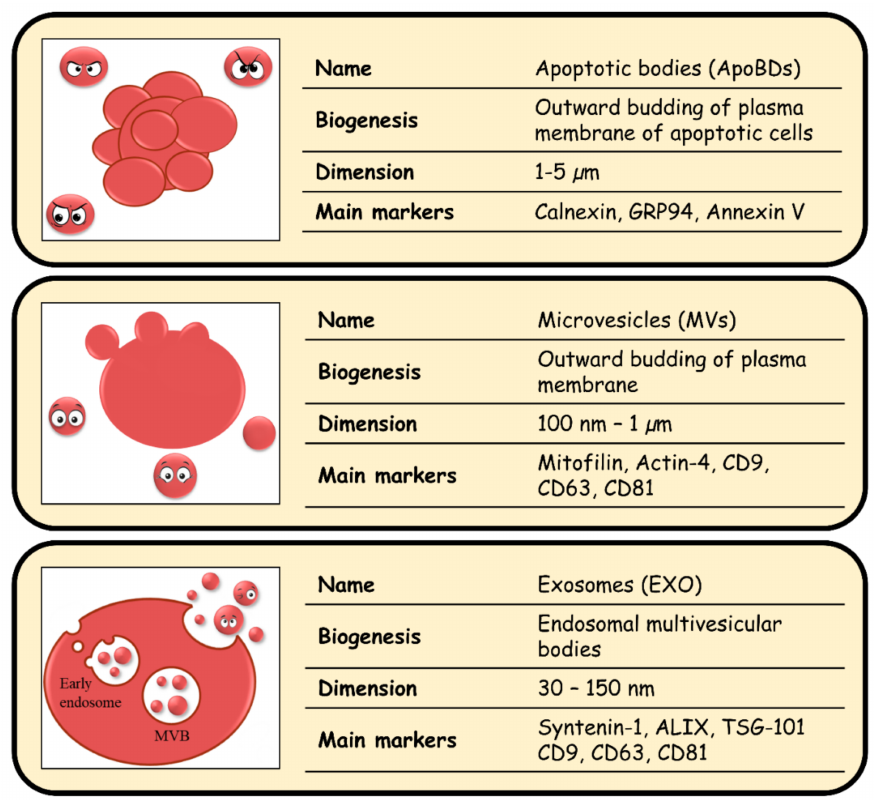
Figure 1. Extracellular Vesicles (EVs)-ID-CARD. Schematic representation of the three main classes of EVs. For each group, biogenesis, dimension, and markers are